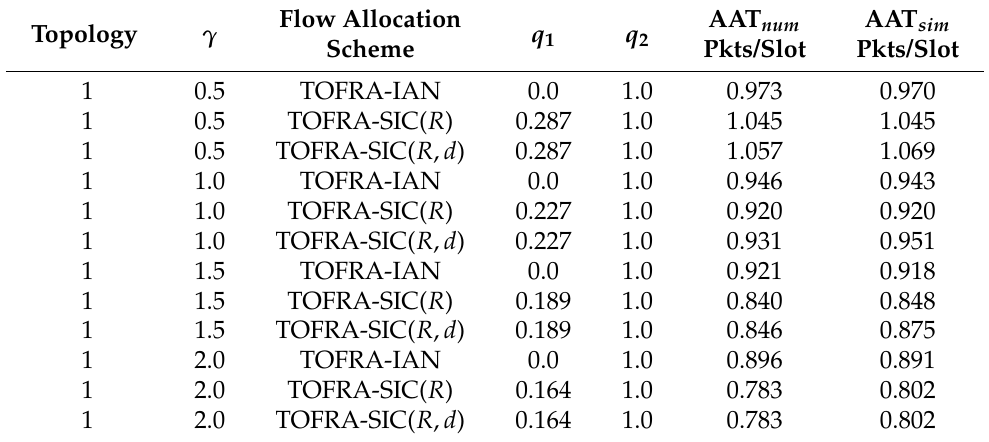
Table 3. Simulation vs. numerical results for the AAT achieved by each TOFRA variant. Topology 1.